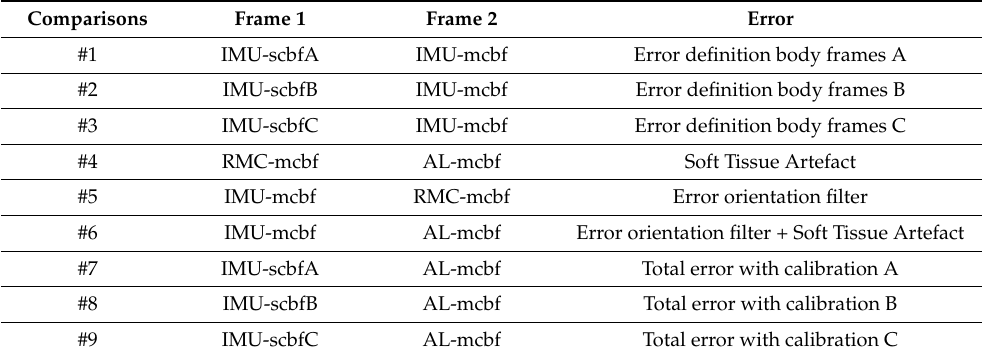
Table 1. Comparisons between the different body frames and the error that the difference between frames